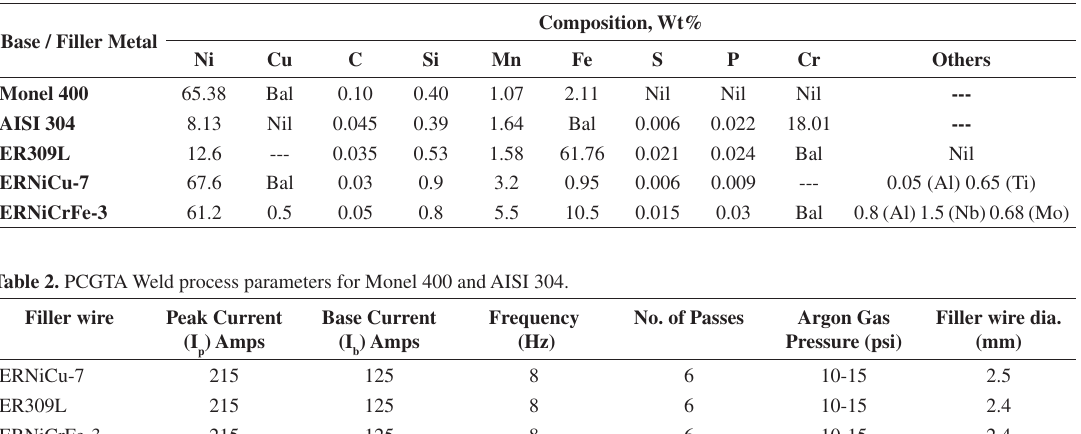
Table 1. Chemical composition of base and filler metals.